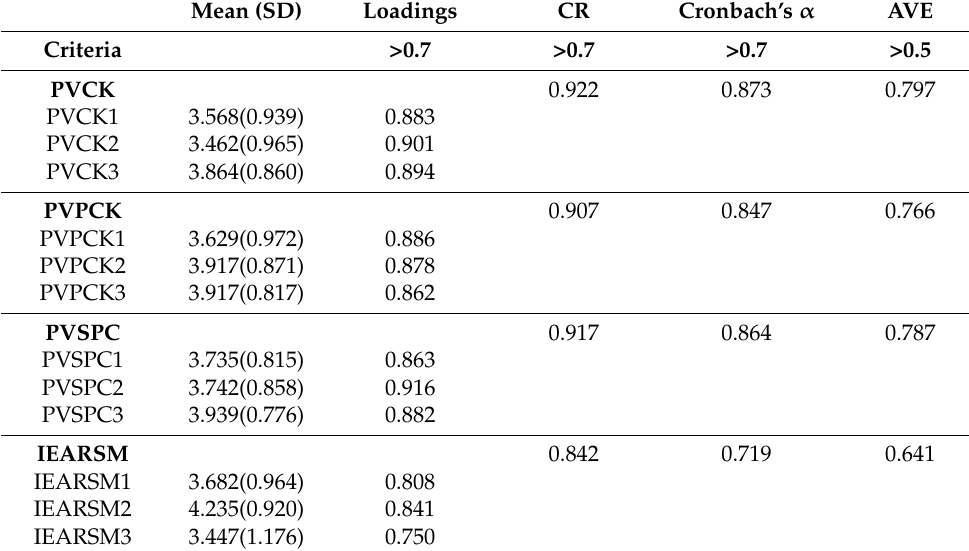
Table 3. The results for the measurement models.